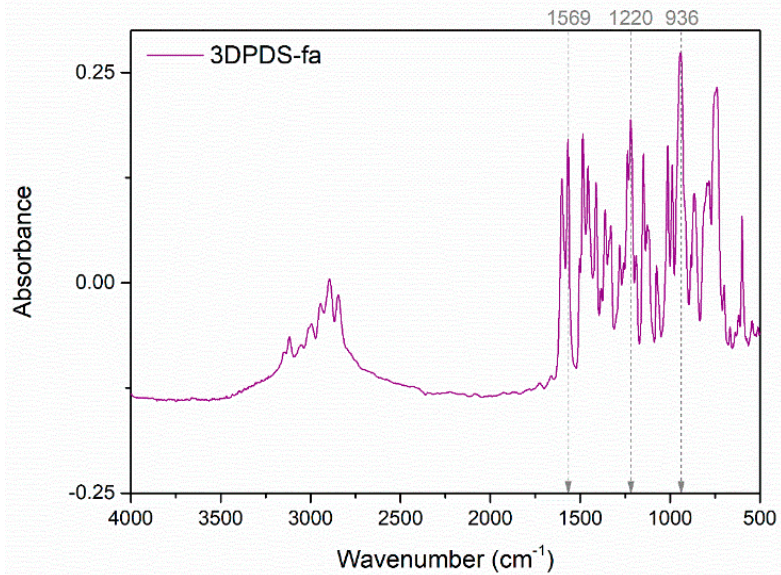
Figure A5. FTIR spectrum of 4DPDS-fa.